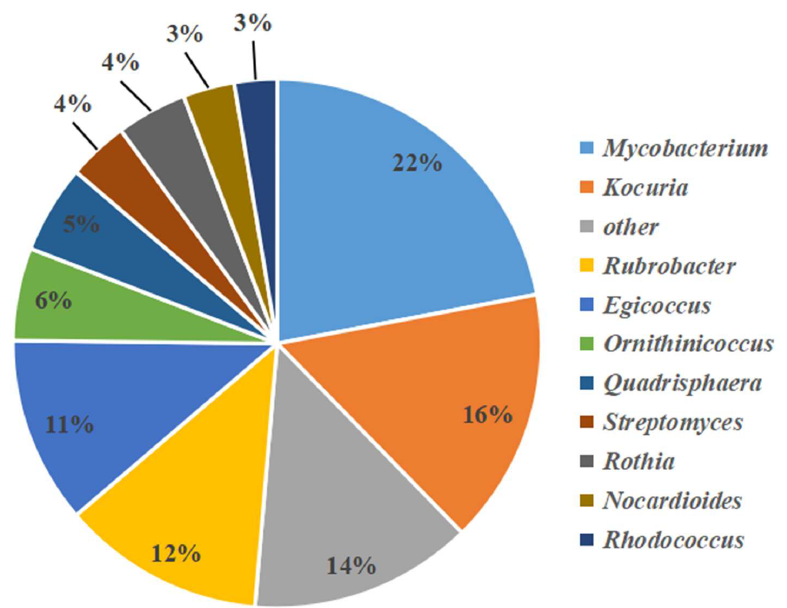
Figure 3. Pie chart showing the percentage relative abundance of actinobacteria genera from samples analyzed by high-throughput sequencing.